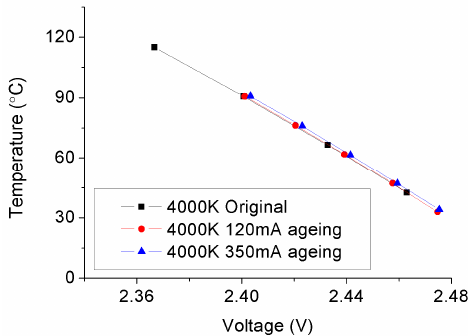
Figure 6. Temperature-voltage curves of the 4000 °K samples before and after SSADTs with 2046 h.